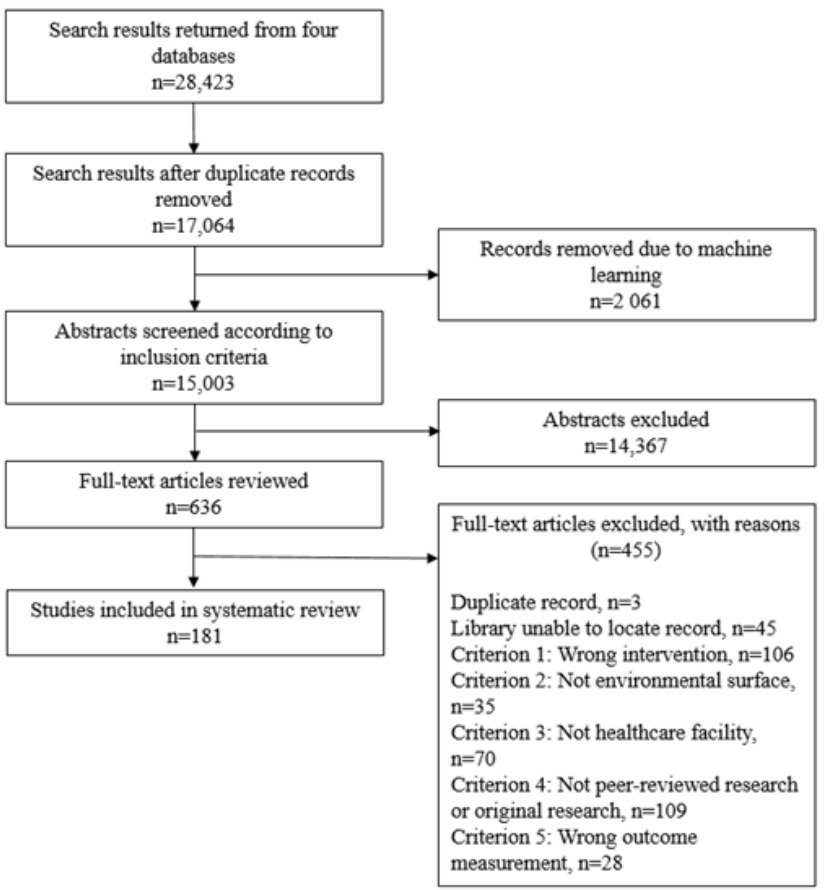
Figure 2. PRISMA flowchart of systematic review.